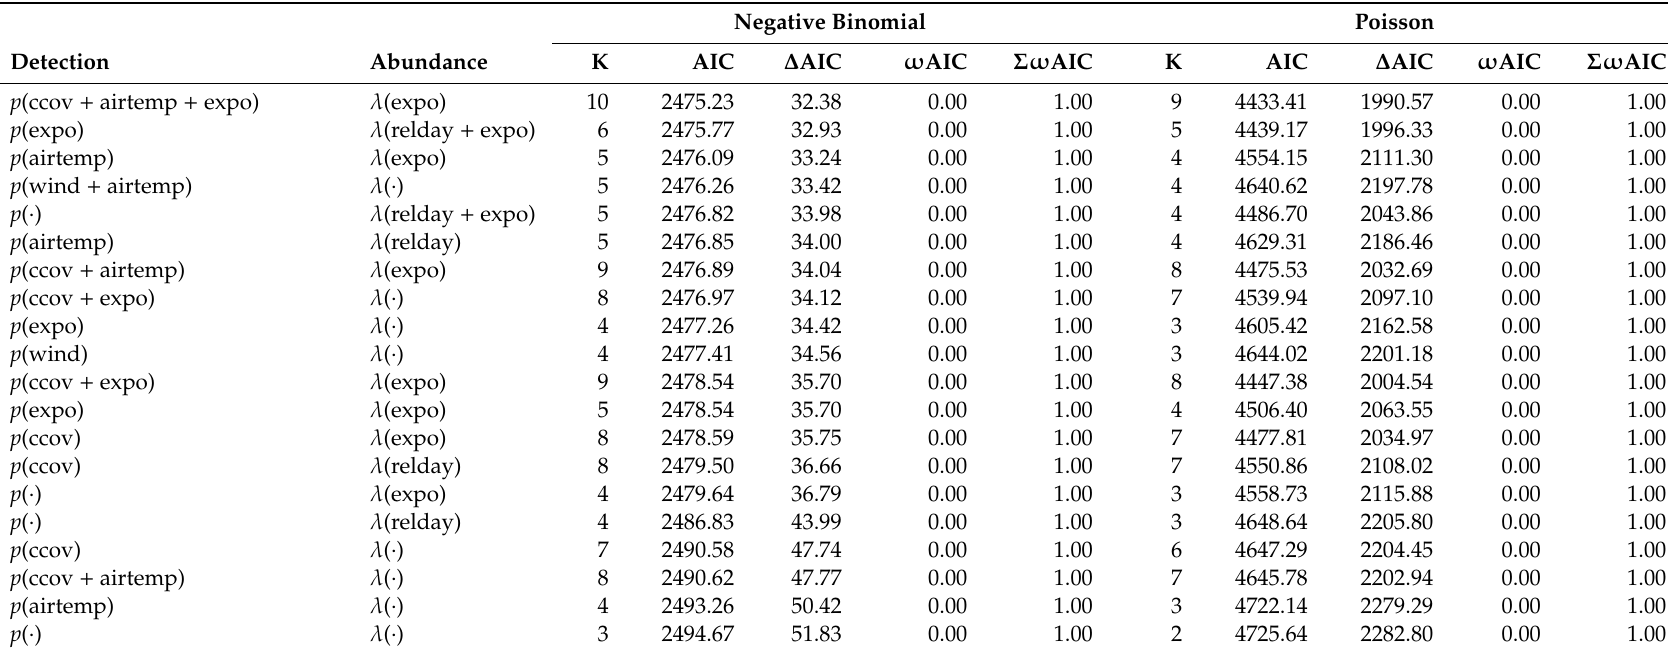
Table A2. Goodness of fit test statistics from a parametric bootstrap of 1000 simulations from the AIC-top model. SSE is the sums of squares and Freeman Tukey compares the observed data to that expected under the model. In the table, θ obs is the observed test statistic, i.e., that calculated from the actual data, θ boot is the statistic from data generated from the model, the mean and standard deviation of the di ff erences are the di ff erence from the observed and each simulated data set, and Pr( θ boot > θ obs) is the probability that the observed statistic is greater than expected as compared to the bootstrapped distribution (i.e., p < 0.05 could be